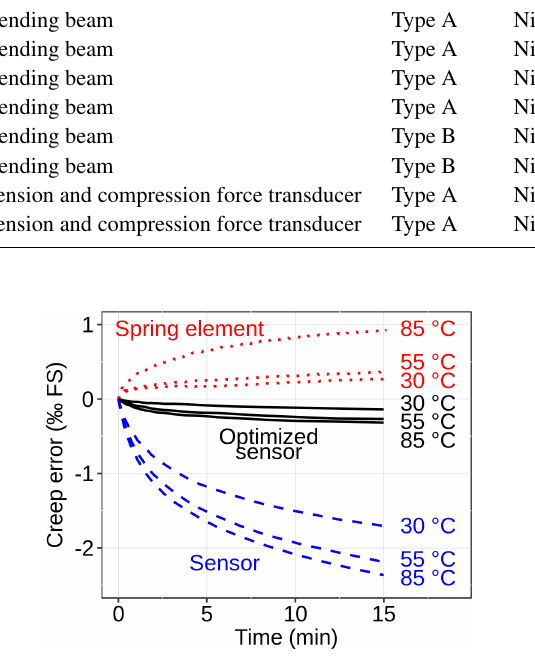
Figure 10. Time-dependent creep error of a raw bending-beam- type spring element (dotted red lines), a sensor equipped with strain gauges of Ni 90 Cr 10 − C on polyimide type B (blue dashed lines) with regular transverse sensitivity ( k T /k L = 50%) and an optimized sensor equipped with strain gauges of Ni 90 Cr 10 − C and strongly reduced transverse sensitivity ( k T /k L = 10%) on polyimide type A (black solid lines) for three different